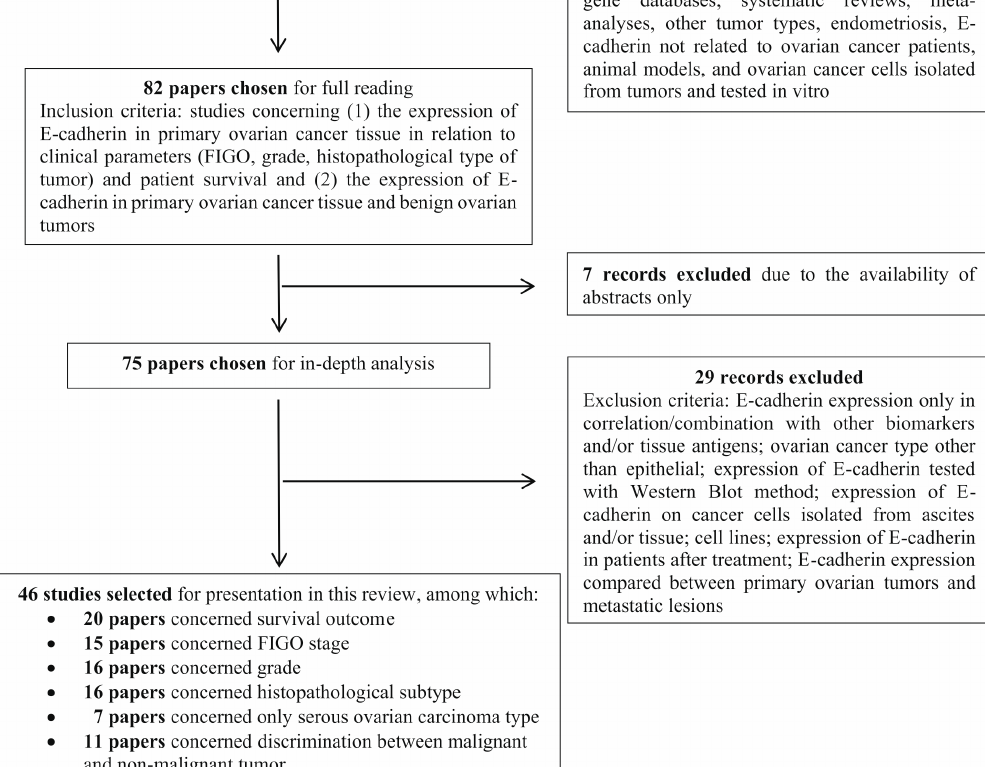
Figure 1. Flow diagram of study selection.